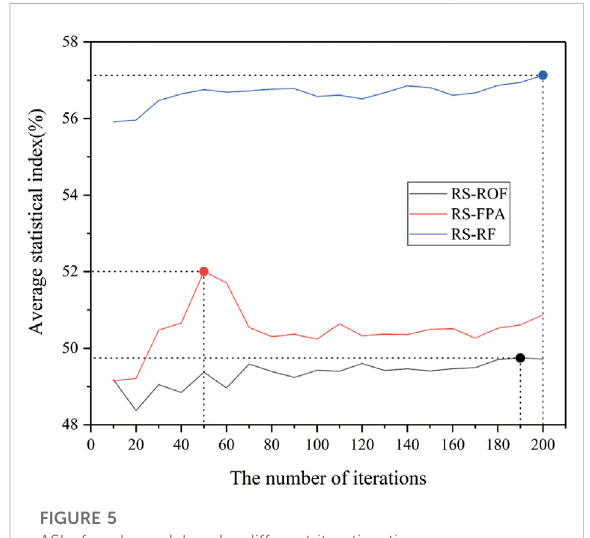
FIGURE 5 ASI of each model under different iteration times.